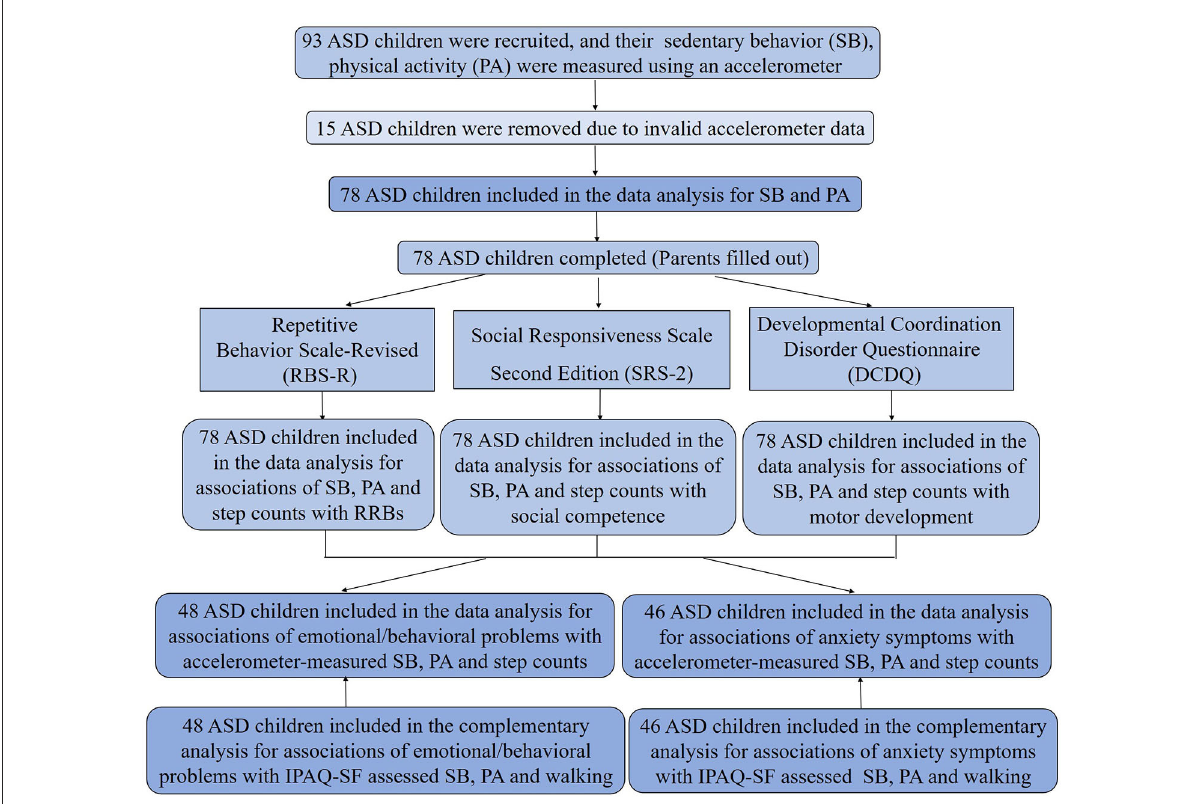
FIGURE1 Flow diagram of study participant enrollment. IPAQ-SF, International Physical Activity Questionnaire-Short